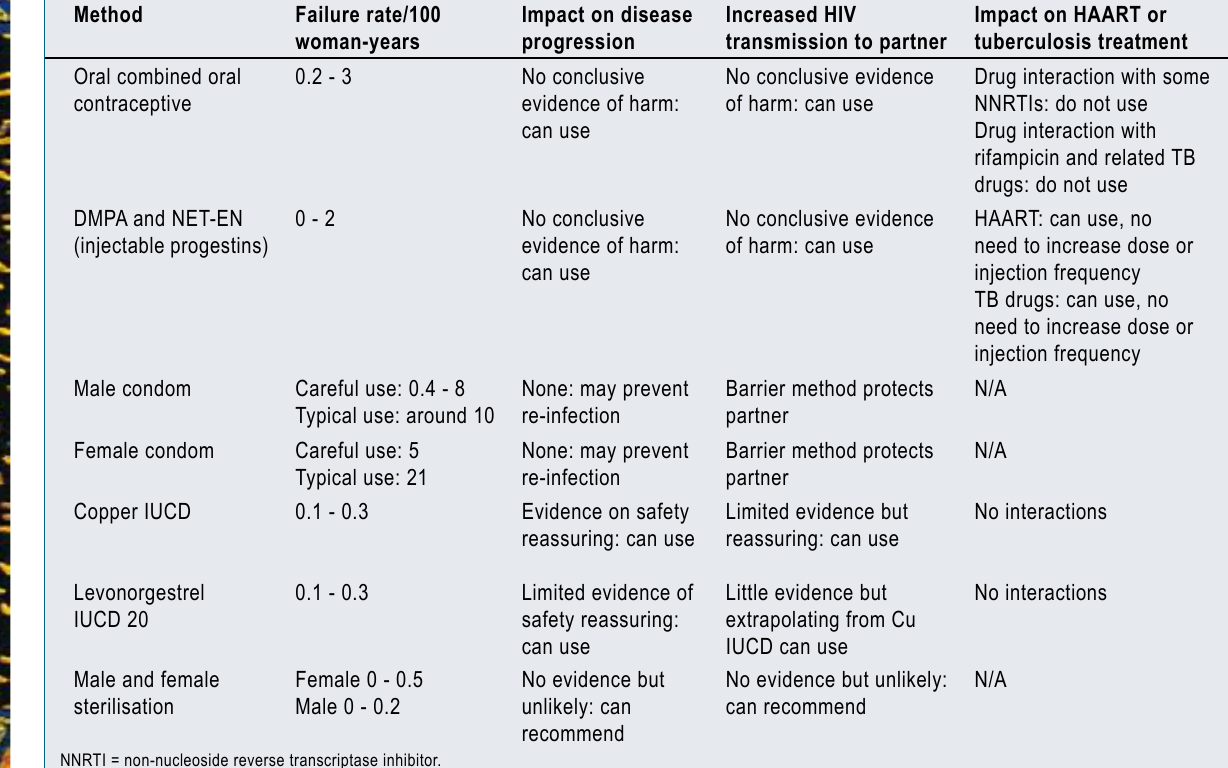
TABLE I. EFFECTIVENESS OF THE COMMON CONTRACEPTIVE METHODS, AND THEIR SAFETY IN HIV